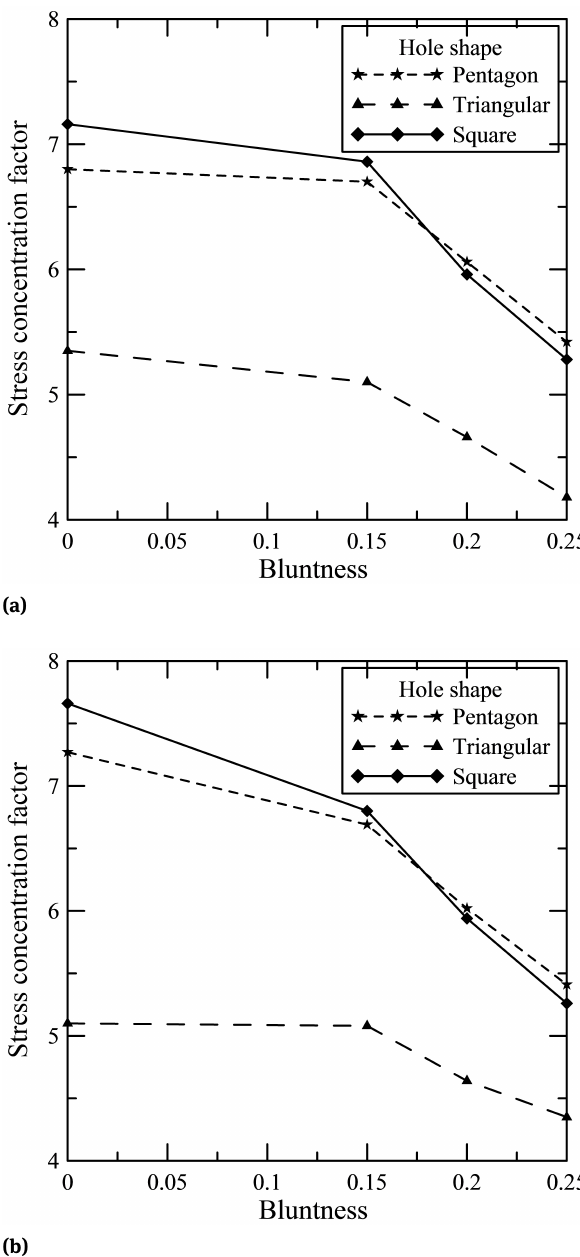
Figure 11: Effect of bluntness on: (a) stress concentration factor and (b) strain concentration